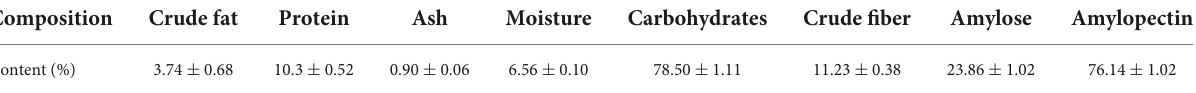
TABLE 1 The nutritional content of millet